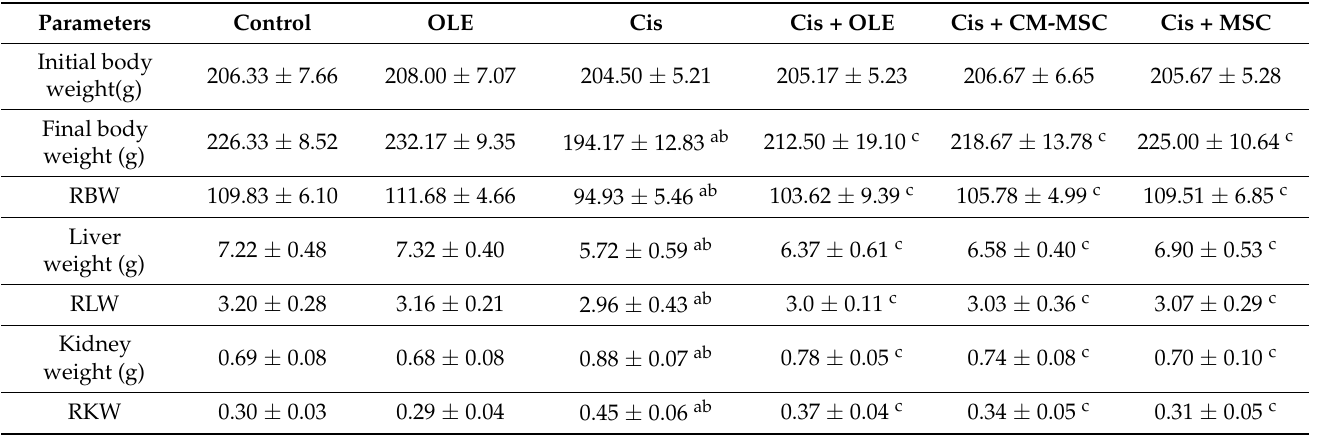
Table 2. Effects of olive leaf extract (OLE), mesenchymal stem cells (MSC), CM-MSC, cisplatin and their combination, on body, liver, and renal weight of